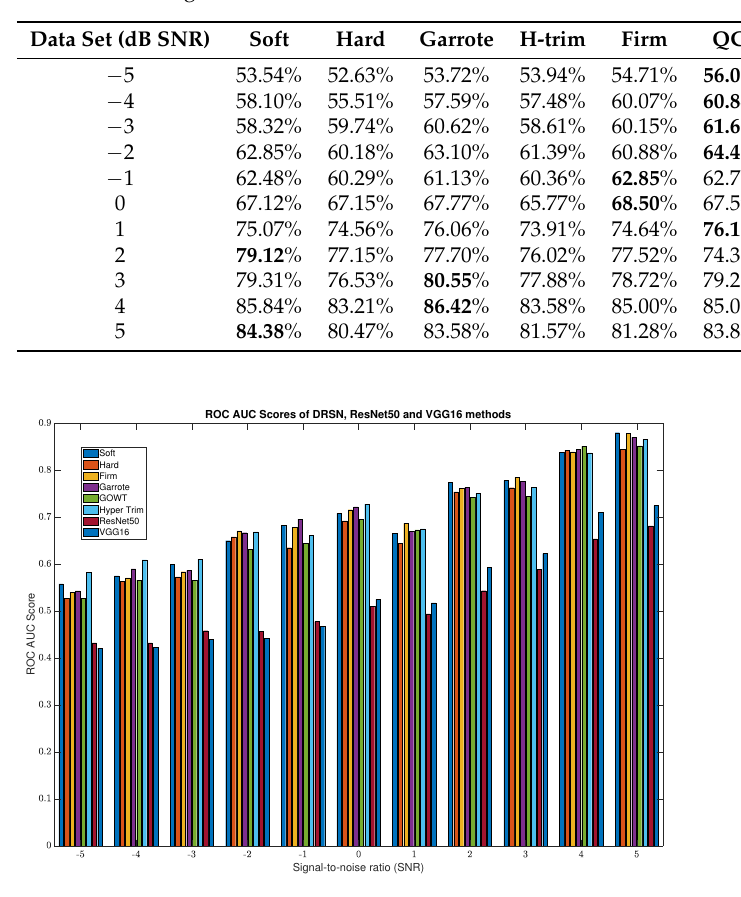
Figure 10. Bar graph of average receiving operating characteristics area under the curve score of alternative thresholding, ResNet50 and VGG16 methods. DRSN with RSBU-1 is used to implement Soft, Hard and Garrote thresholding, DRSN with RSBU-2 is used to implement H-trim, Firm and QCT